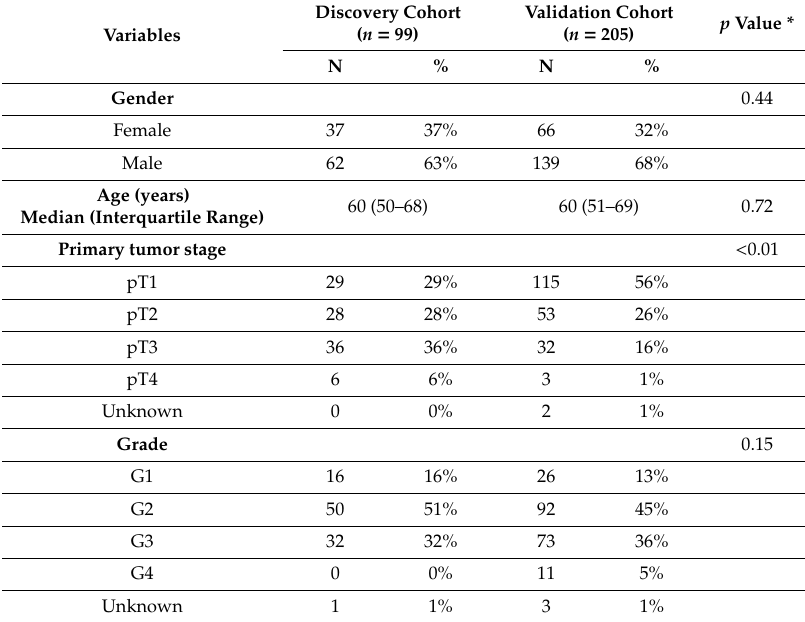
Table 1. Clinicopathologic characteristics of patients in the discovery and validation